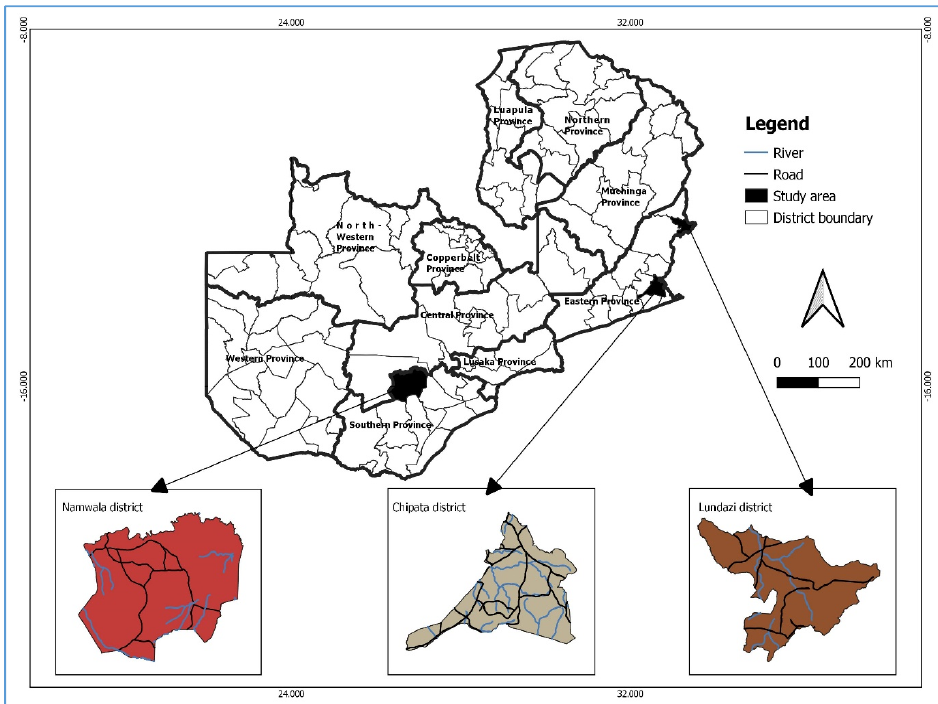
Figure 1. Map of Zambia depicting the three study